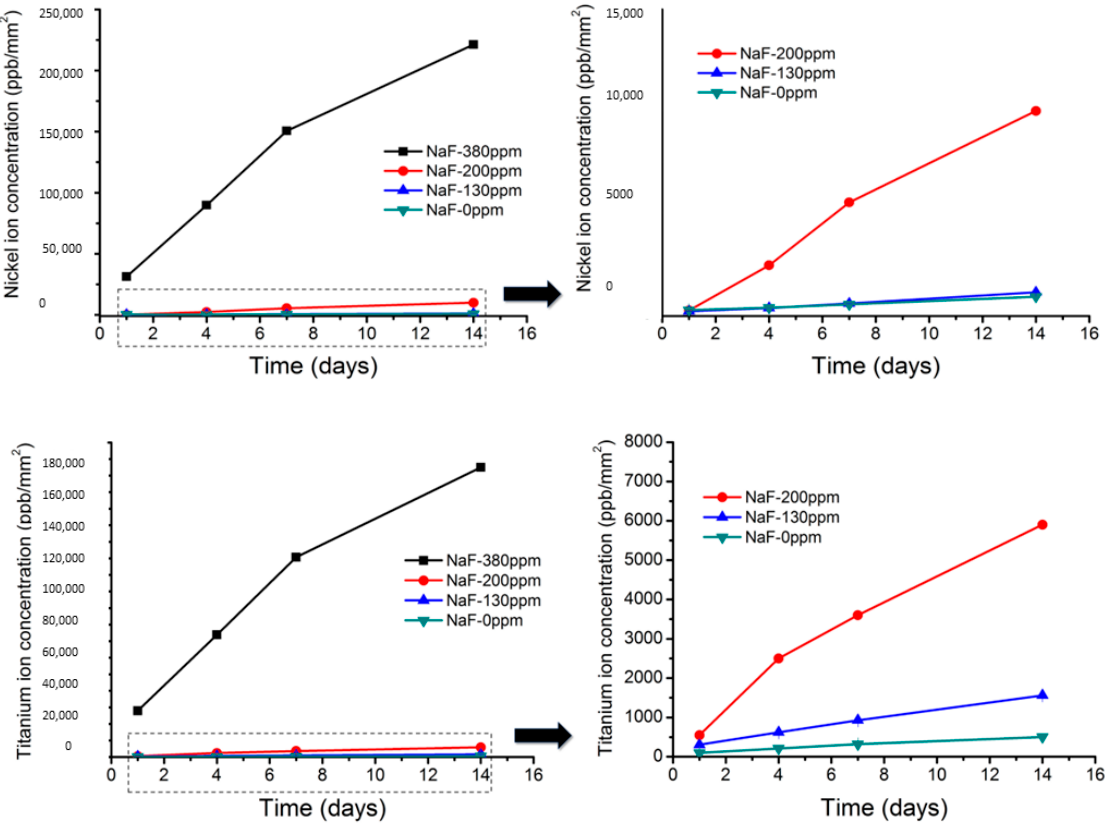
Figure 6. Nickel and titanium ion release at different times of immersion and at different fluoride concentrations solutions. At concentrations of 130 and 200 ppm, the figure has been magnified. The contact surface of the archwire with the solution is 100 mm 2 .